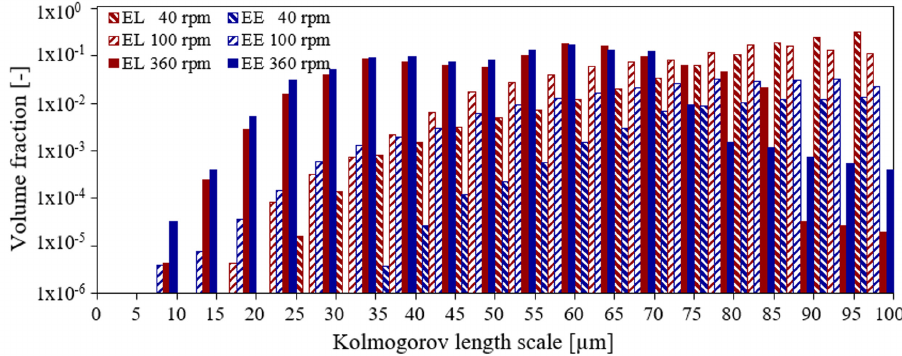
Figure 9. Liquid volume fraction distribution of the Kolmogorov length scale up to 100 µ m for conditions 7, 4, and 8 for the EL and the EE